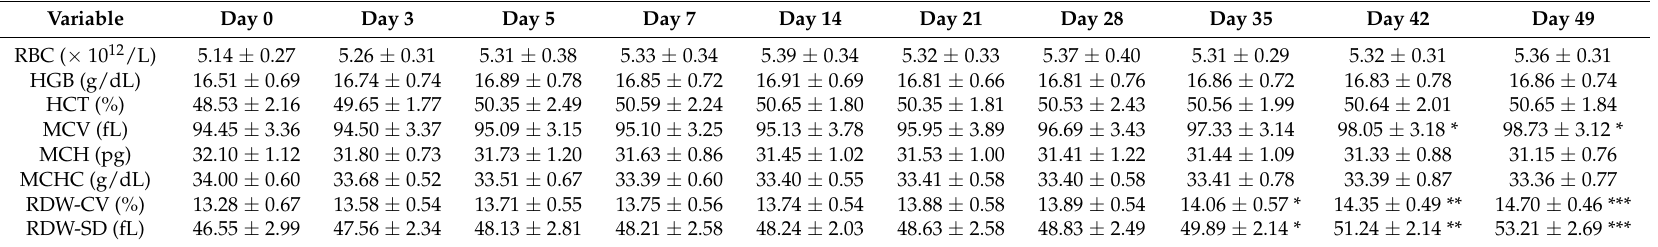
Table 1. Hematological parameters of red blood cells (RBCs) during storage in